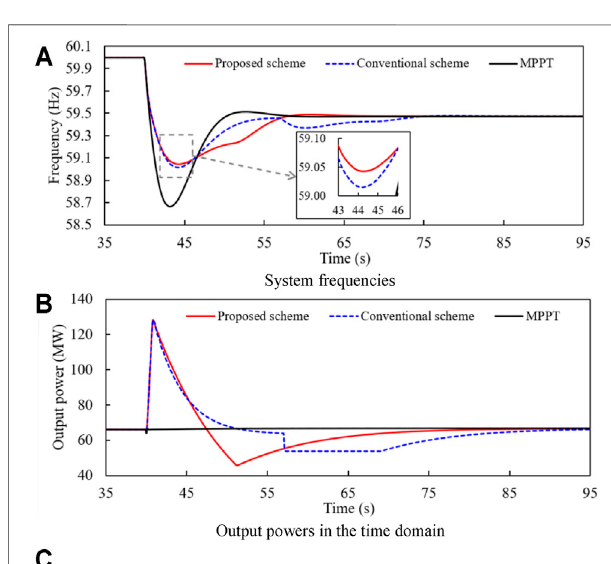
Frontiers in Energy Research |